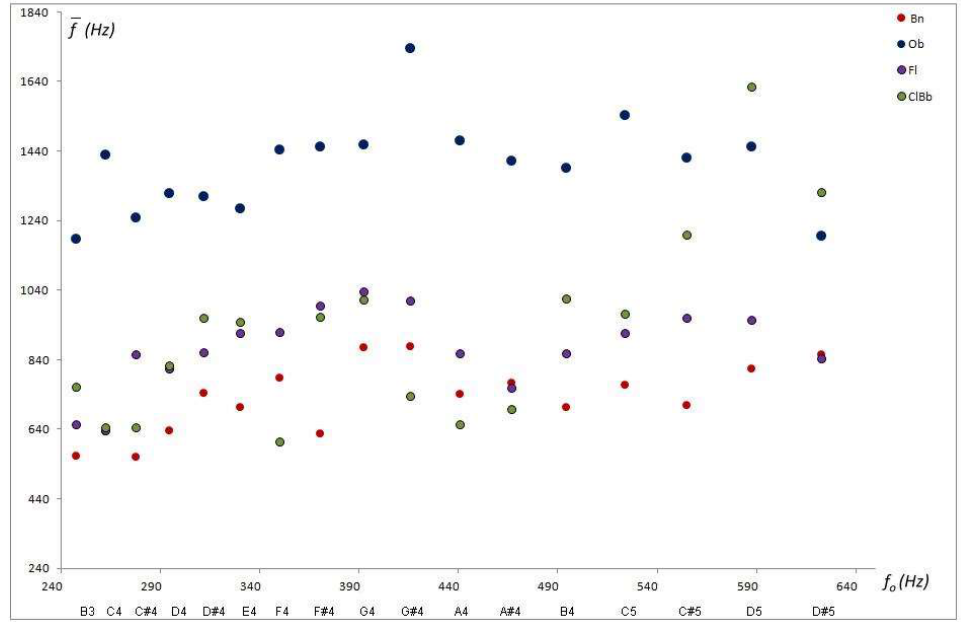
Figure 2. Variation of the centroid concerning the common tessitura of the wooden aerophones studied: Bassoon (Bn), Oboe (Ob), Transverse Flute (Fl), Clarinet in Bb (ClBb). For comparison purposes, the location of the musical notes of the scale below the abscissa axis is also included.